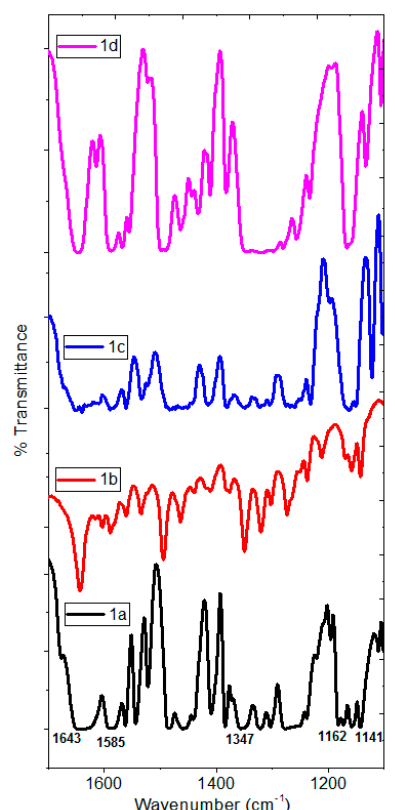
Figure 5. IR spectra of heptacoordinated organotin (IV) complexes in films.